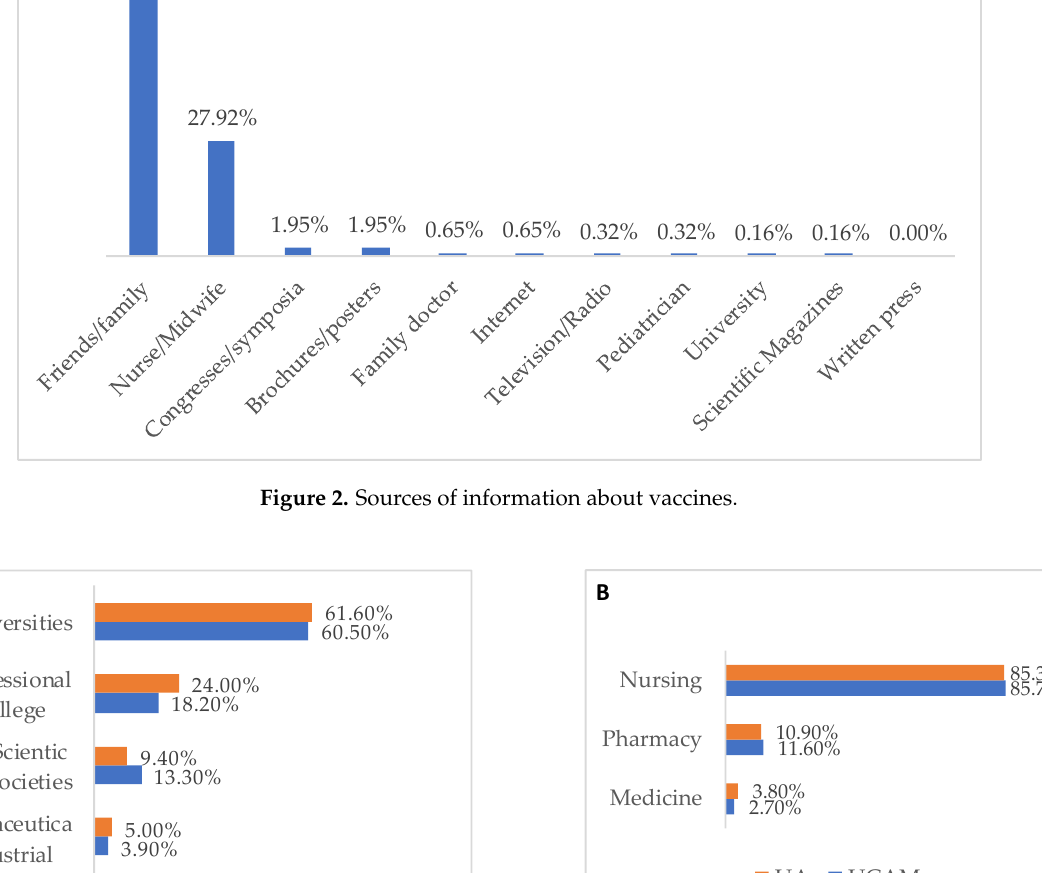
Figure 3. Opinion about who should receive vaccine-related education ( A ) from who should provide it ( B ).